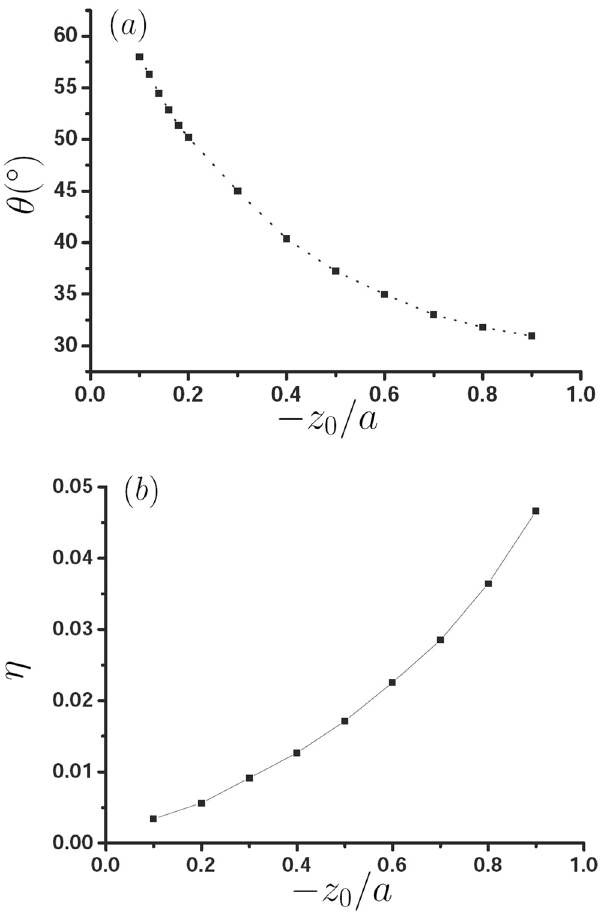
Figure 6. ( a ) Variation of the optimal θ with − z 0 , ( b ) the optimal spin separation as a function of − z 0